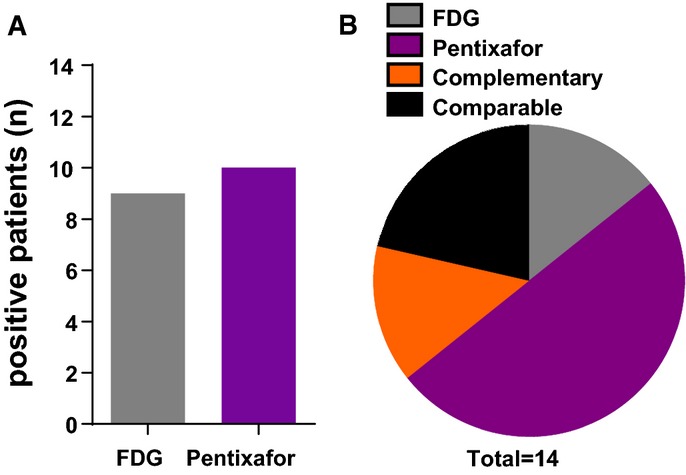
Visual comparison of [18F]FDG- and [68Ga]Pentixafor PET scans
Number of patients with visual positivity for the indicated PET tracer (total: n = 14).

Number of patients (total n = 14) for whom imaging with [18F]FDG PET (FDG, n = 2) or [68Ga]Pentixafor PET (Pentixafor, n = 7) was superior, with comparable positivity (comparable, n = 3), and with dual imaging providing complementary visual information (complementary, n = 2).